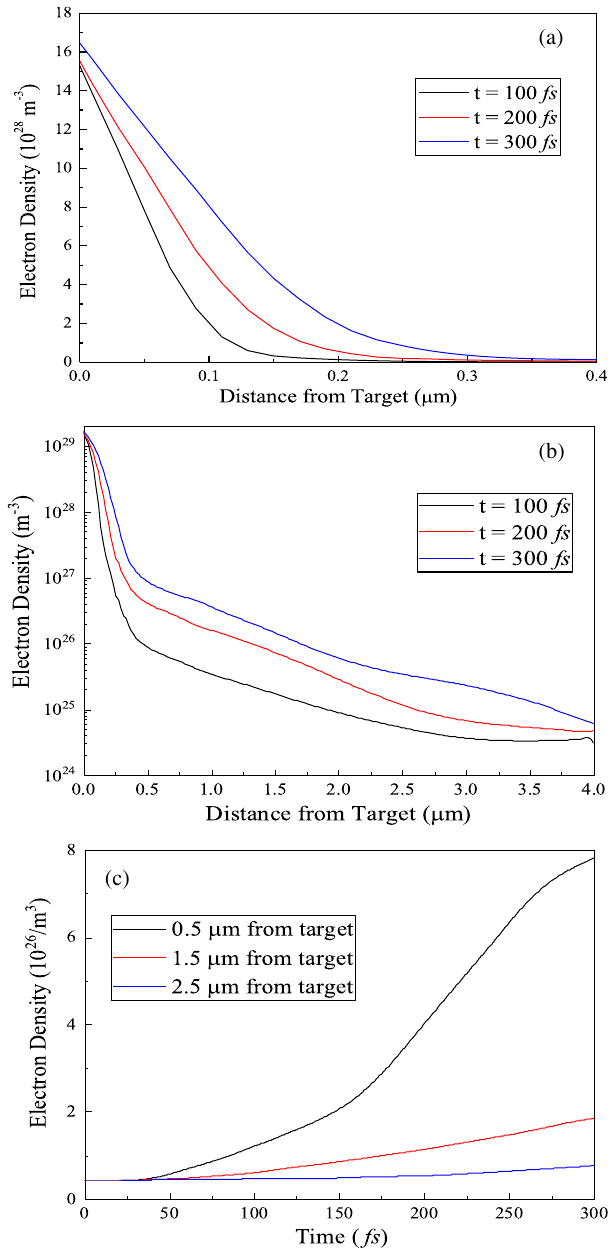
FIG. 4. Electron density versus distance from the back target surface for submicrometric length (a) and for micrometric lengths (b) at three different times from the laser shot: 100, 200, and 300 fs. Electron density from the back target surface versus time, for three distances from the target: 0.5, 1.5, and 2 . 5 μ m (c). from the rear target surface and reduces to about one order of magnitude at about 0 . 1 μ m from the rear target surface, at 100 fs, while a significant increment in the value occurs for a time of about 300 fs. More details of the forward emitted electron density versus target distance, for the lower levels of electron density, as calculated by the PIC simulation, are reported in the plot of Fig. 4(b).